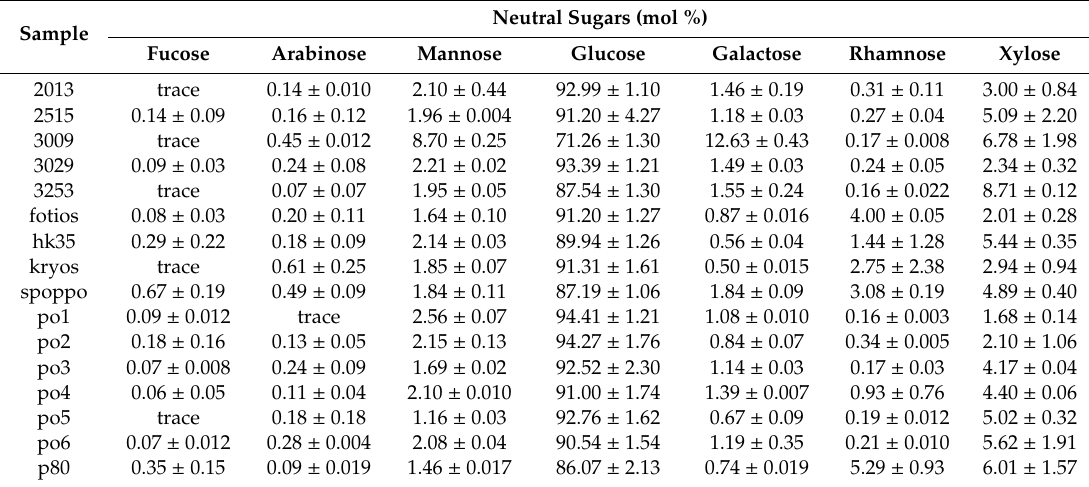
Table 3. Neutral sugars composition of purified basidiocarps (mean ±